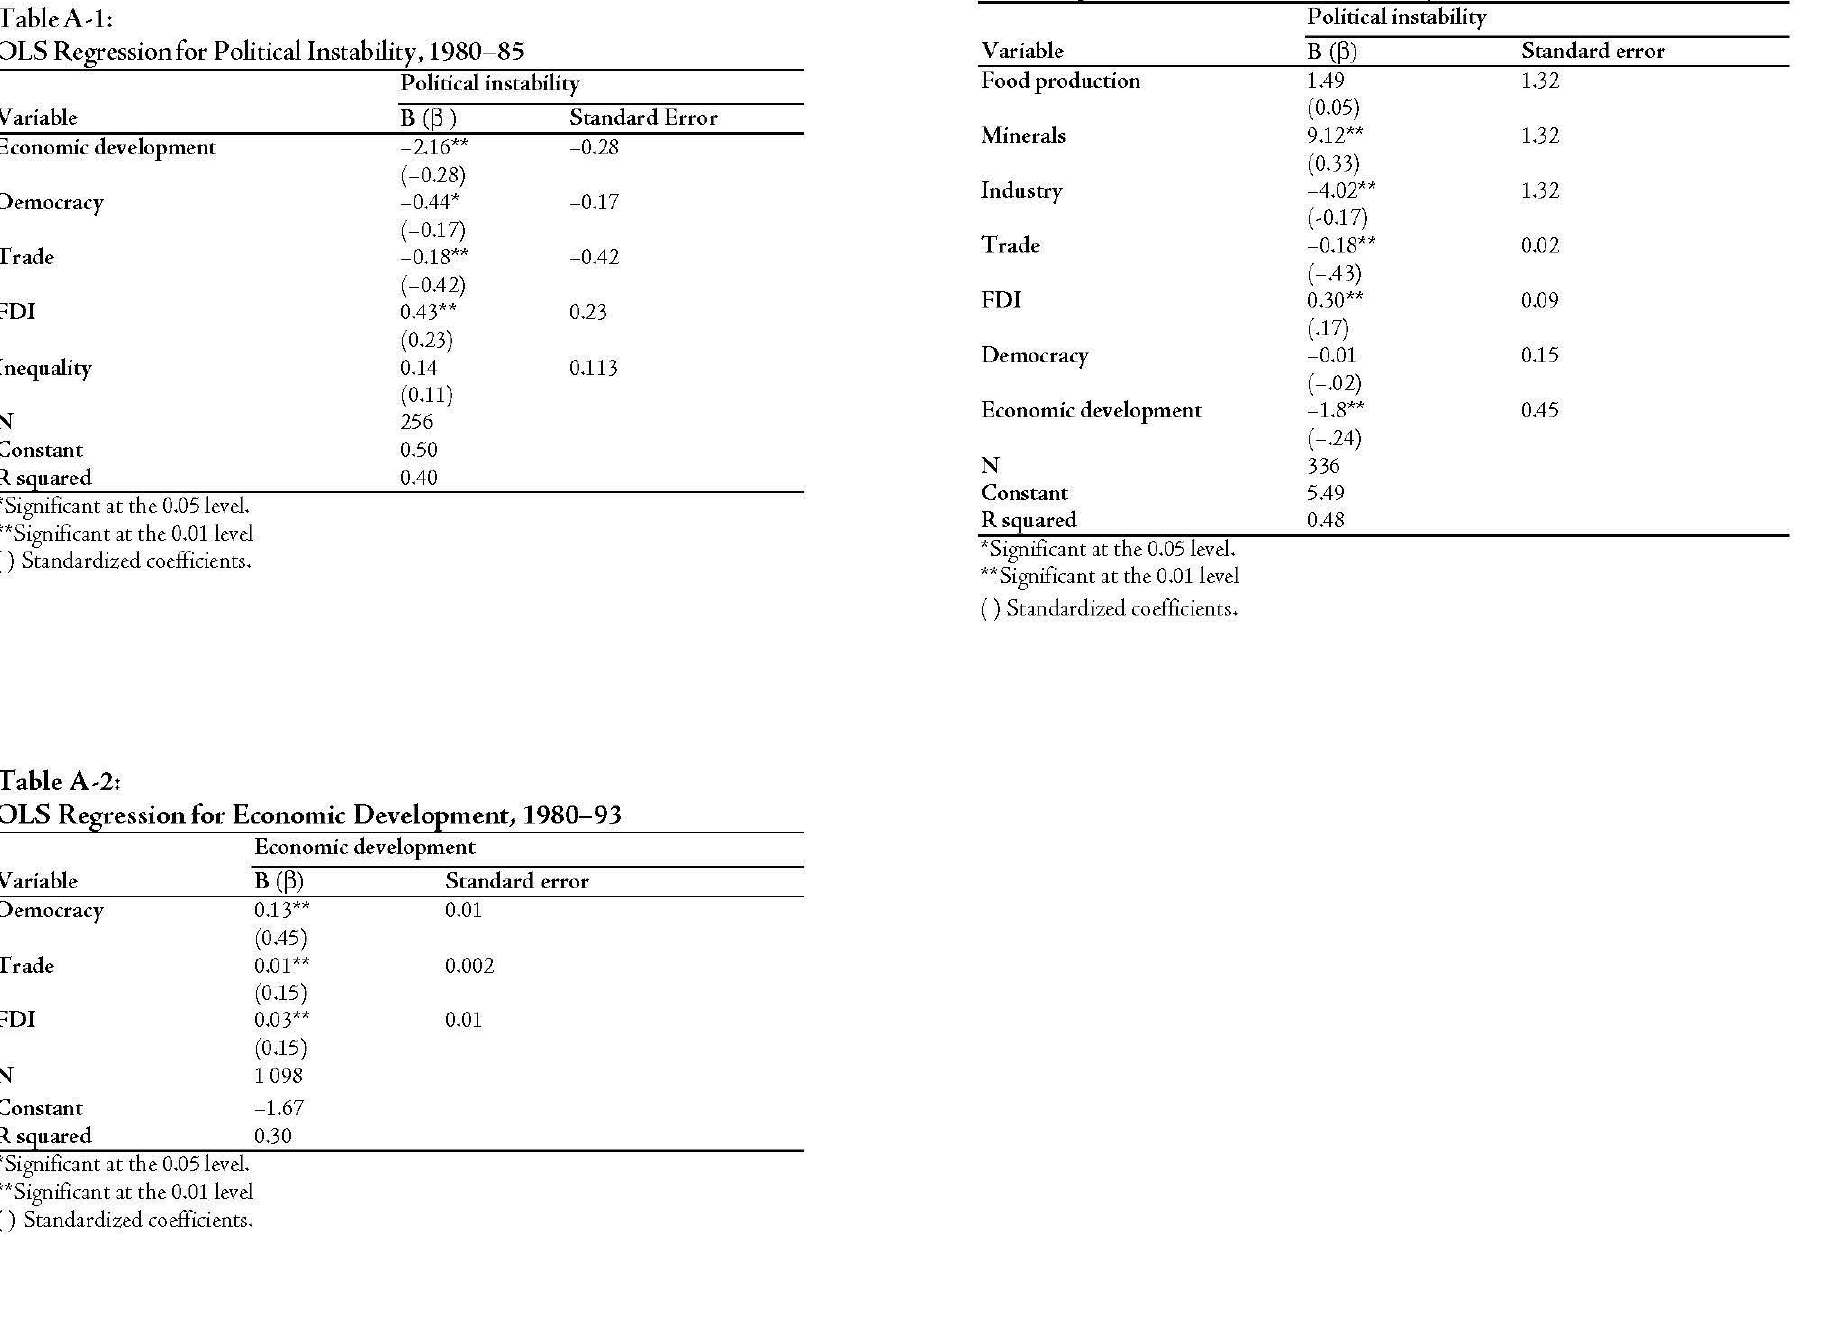
OLS Regression for Political Instability,